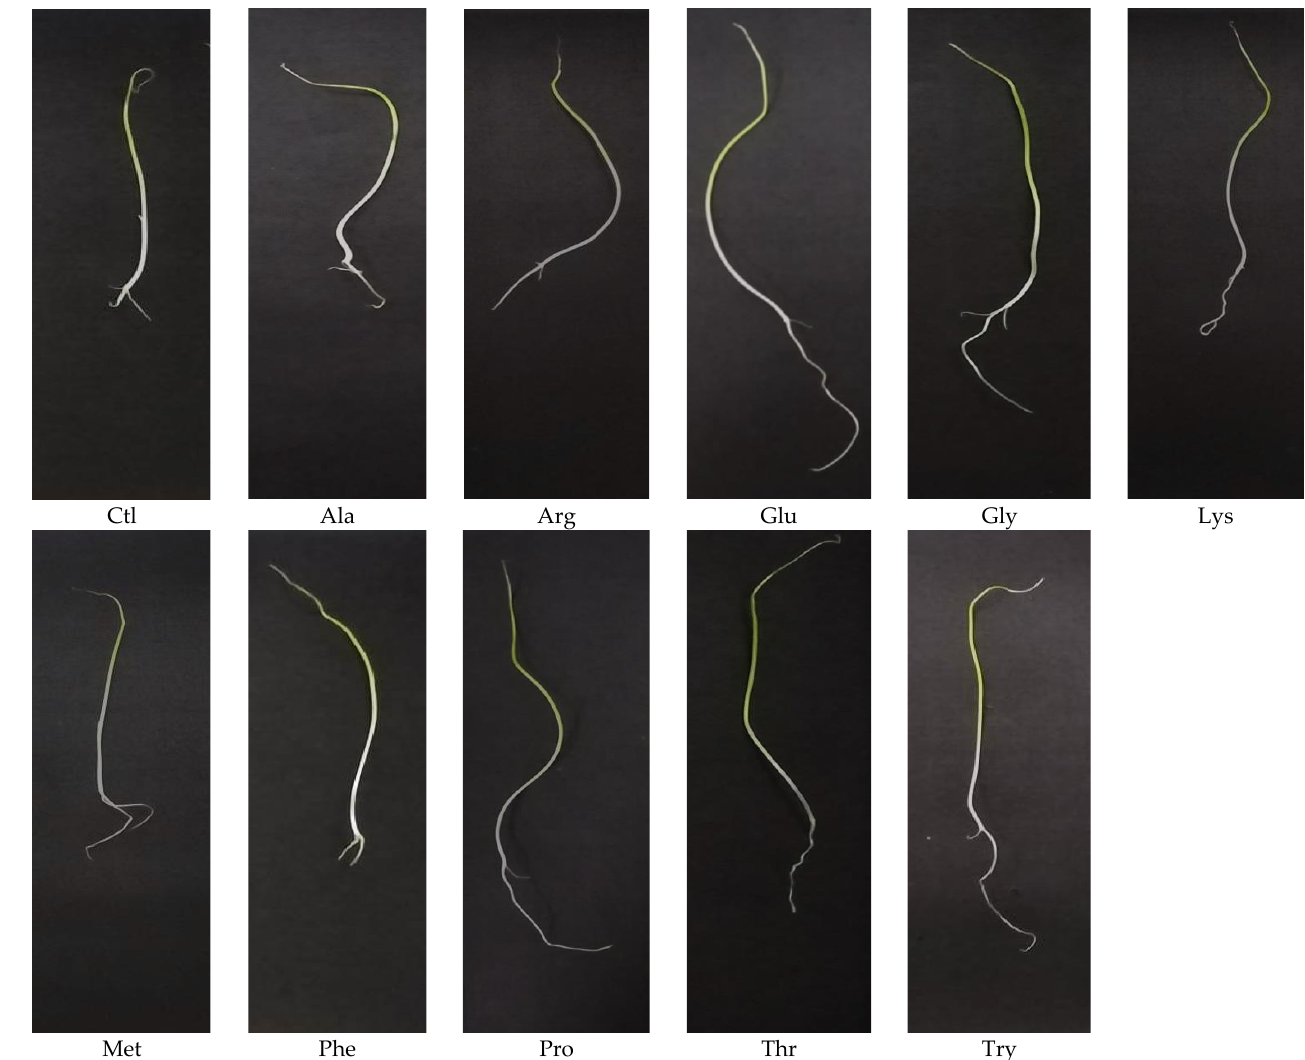
Figure 9. Primed onion seedlings with different exogenous amino acids. Ctl (Control); Ala (Alanine); Arg (Arginine); Glu (Glutamine); Gly (Glycine); Lys (Lysine); Met (Methionine); Phy (Phenylalanine); Pro (Proline); Thr (threonine); Try (tryptophan).